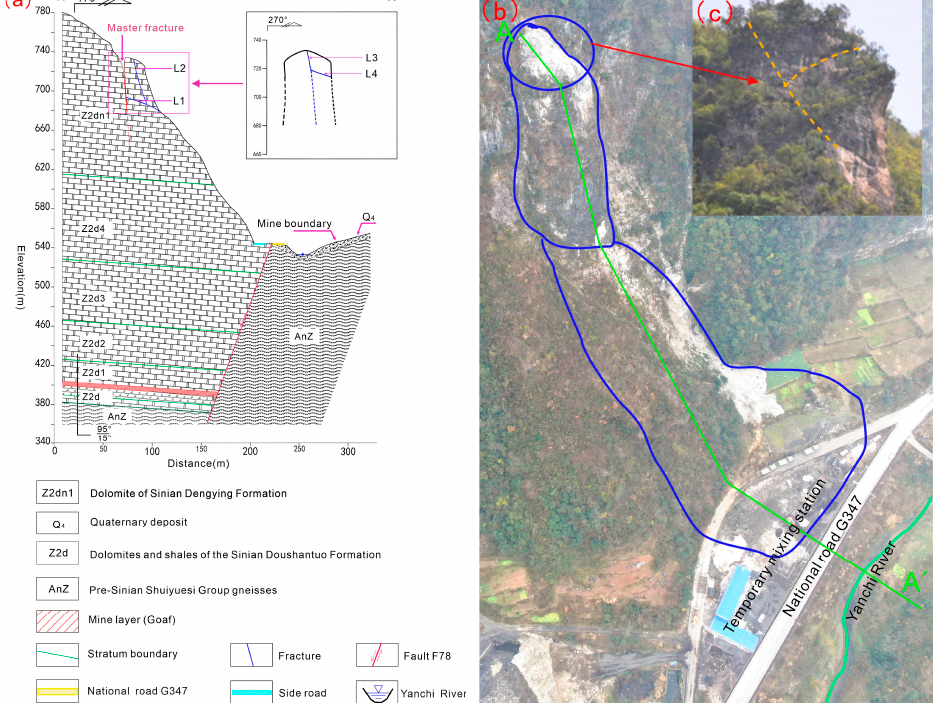
Figure 2. Geological profile of the perilous rock mass Yizhuxiang: ( a ) Sectional view of Yizhuxiang collapse body; ( b ) Photos of the landform before the collapse of the Yizhuxiang collapse; ( c ) Partial photos of the dangerous rocks at the top of the Yizhuxiang collapse before the blasting.